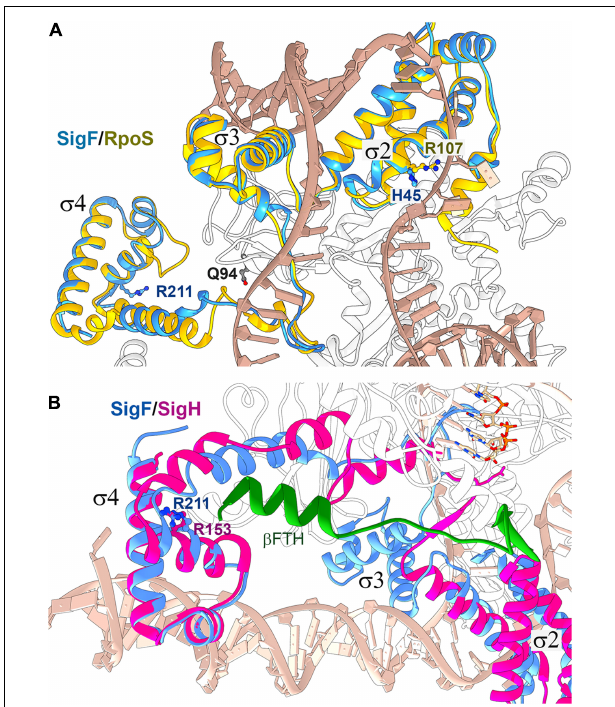
FIGURE 9 | Structure alignment of the Synechocystis SigF with group 2 and ECF sigma factors bound in RNAP holoenzymes. (A) The structure of Synechocystis SigF was predicted using I-TASSER (C-score = 0.98; Yang et al., 2015) and aligned with the crystal structure of the transcription initiation complex from E. coli containing RpoS (PDB code 5IPL; Liu et al., 2016) using Chimera software (Pettersen et al., 2004). RpoS is depicted in gold, SigF in blue, DNA in tan and the RNAP β ’ subunit in white. Residues in SigF that are mutated in rev1 and rev4 strains are shown in dark blue; Q94 corresponds to the E95 residue in the Synechocystis RNAP γ subunit. (B) The predicted structure of SigF was aligned with the crystal structure of the RNAP-SigH transcription initiation complex from Mycobacterium tuberculosis (PDB code 6DV9; Li et al., 2019). ECF sigma factors lack the σ 3 domain, however, the SigF R211 residue mutated in rev4 is highly conserved in ECF sigma factors (R153 in SigH; Li et al., 2019). SigH is depicted in magenta, SigF in blue, RNAP subunit β in white and the C-terminal flap-tip helix of the RNAP- β subunit ( β FTH) in green (see text for